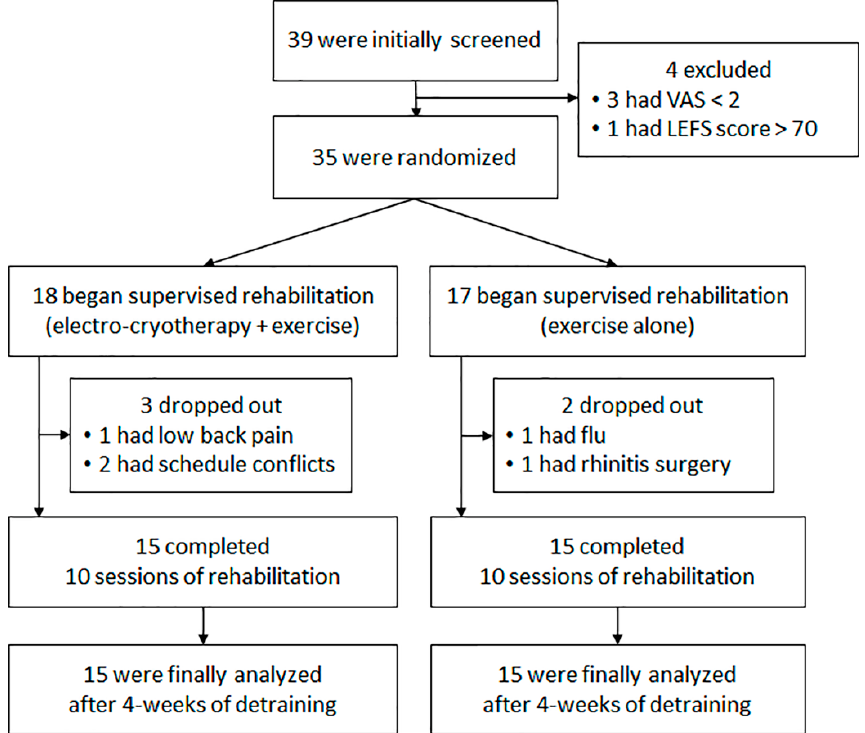
Figure 1. The progress of patients throughout the trial. LEFS: lower extremity functional scale; VAS: visual analog scale.